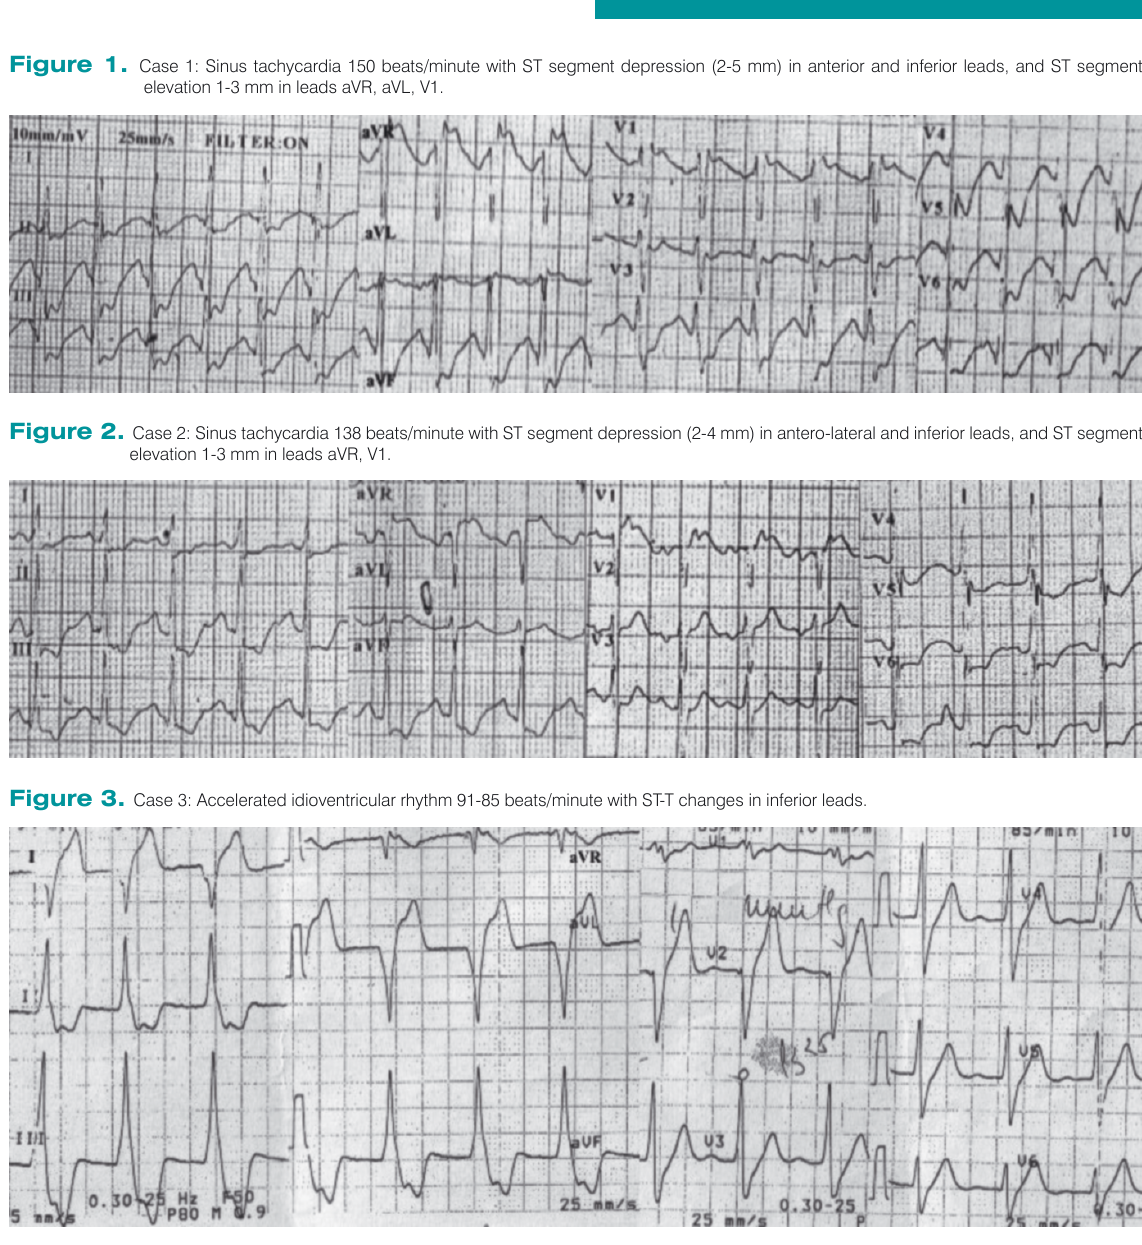
subcutaneous epinephrine (0,5 mg sol. 1:1000, repeated after 15 minutes), intravenous diphenhydramine (50 mg, repeated after 4 hours) and cimetidine (300 mg, repeated after 6 hours), which determined a rapid improvement of clinical picture, BP, and ECG changes. They were all discharged from ED after 24 hours of observation, being asymptomatic and having normal ECG’s.